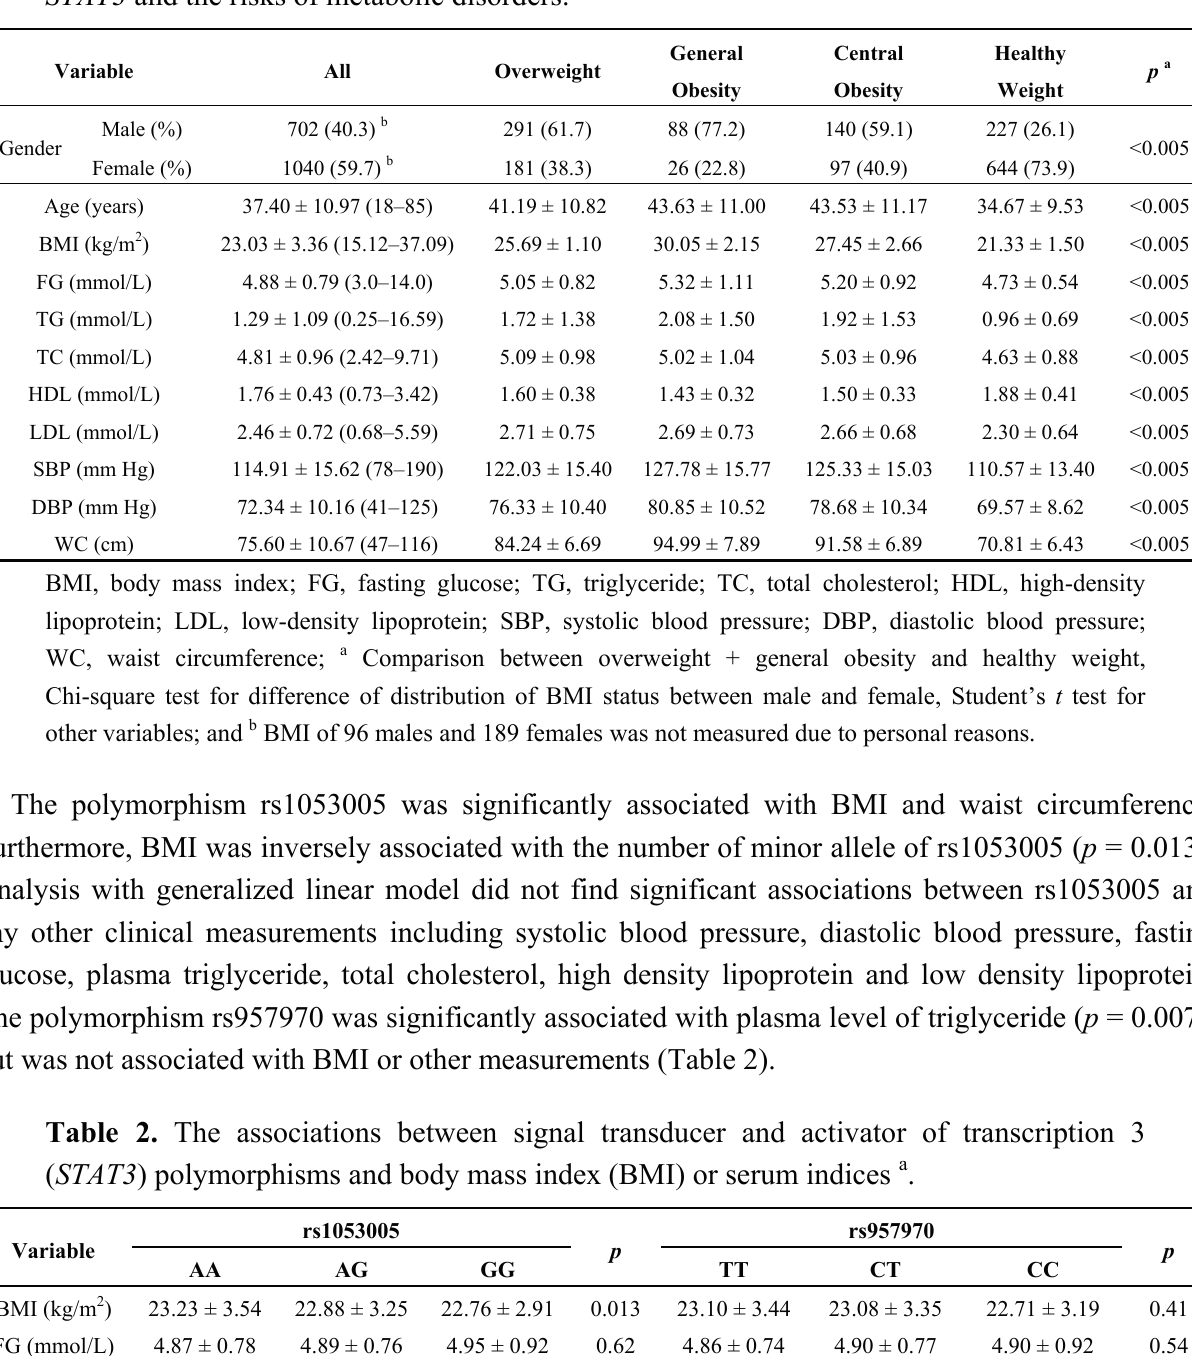
Table 1. Demographic and biochemical characteristics of study on association between STAT3 and the risks of metabolic disorders. Variable All Overweight